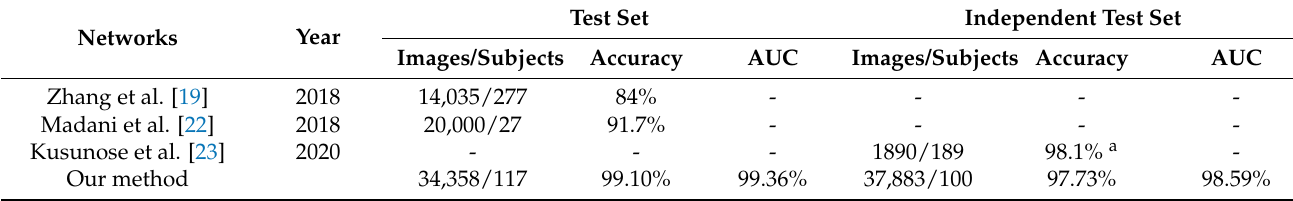
Table 7. The comparison of our method and other recent methods.